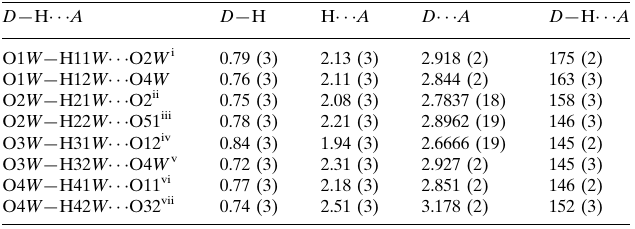
Hydrogen-bond geometry (A˚ , (cid:3) ). D —H (cid:2)(cid:2)(cid:2)